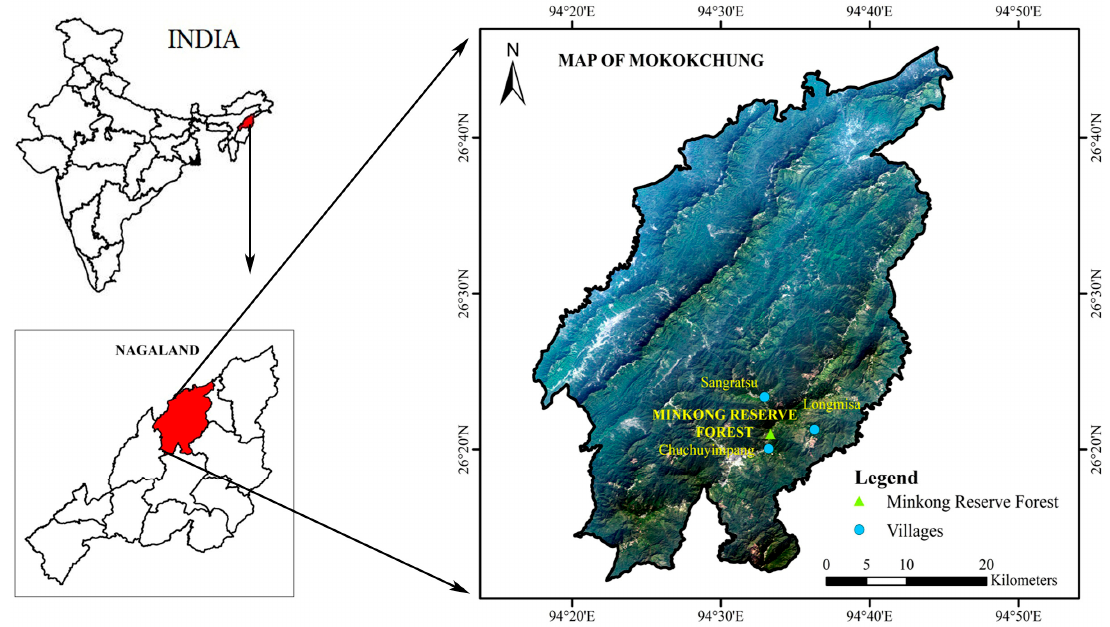
Figure 1. Map of the study site and villages surrounding the Minkong Community Reserve Forest, Mokokchung district, Nagaland, India.